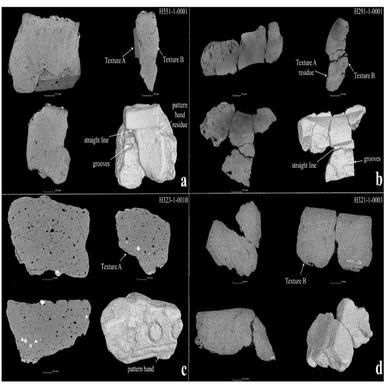
Three-view and 3D-reconstructed photographs of Type I moulds obtained by the micro-CT scanning.